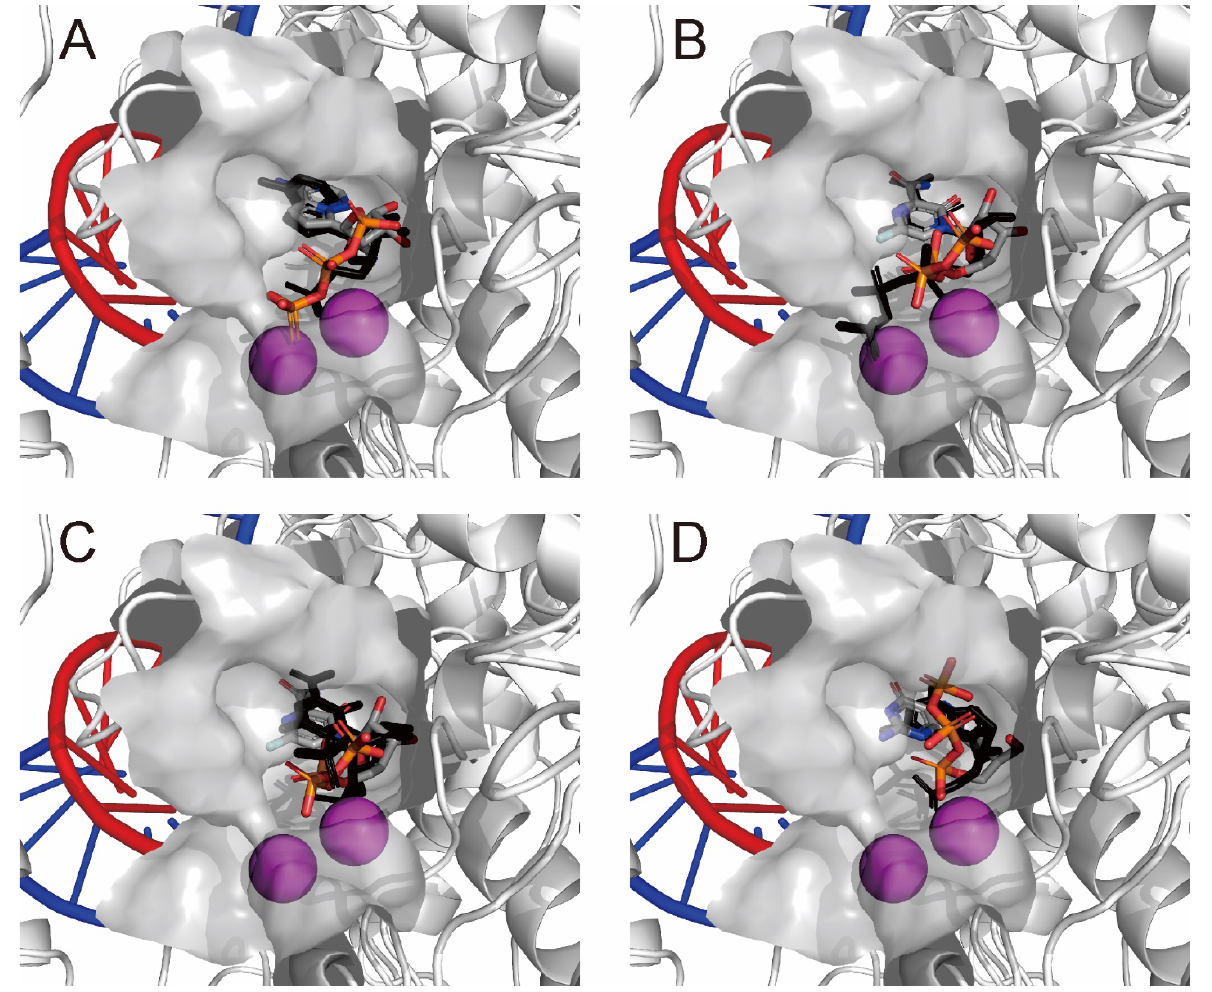
Figure 3. The most stable docking mode obtained from the AutoDock Vina docking simulations using the docking mode from the rDock virtual screenings of the ChEMBL database. ( A ) Binding mode of remdesivir-RTP. ( B , C ) Binding mode of favipiravir-RTP. ( D ) Binding mode of penciclovir triphosphate. RNA-dependent RNA polymerase (nsp12) is presented as a white ribbon. Primer and template RNAs are presented as red and blue coils, respectively. The compound is presented in CPK color using tubes. Magnesium ions are presented as magenta spheres. The experimental drugs remdesivir-RMP ( A , PDB ID: 7BV2), favipiravir-RTP ( B , PDB ID: 7AAP; C , PDB ID: 7CTT), and penciclovir monophosphate ( D , PDB ID: 7DOI) are presented as black tubes. The van der Waals surface of the active site is presented in gray. Hydrogen atoms are not